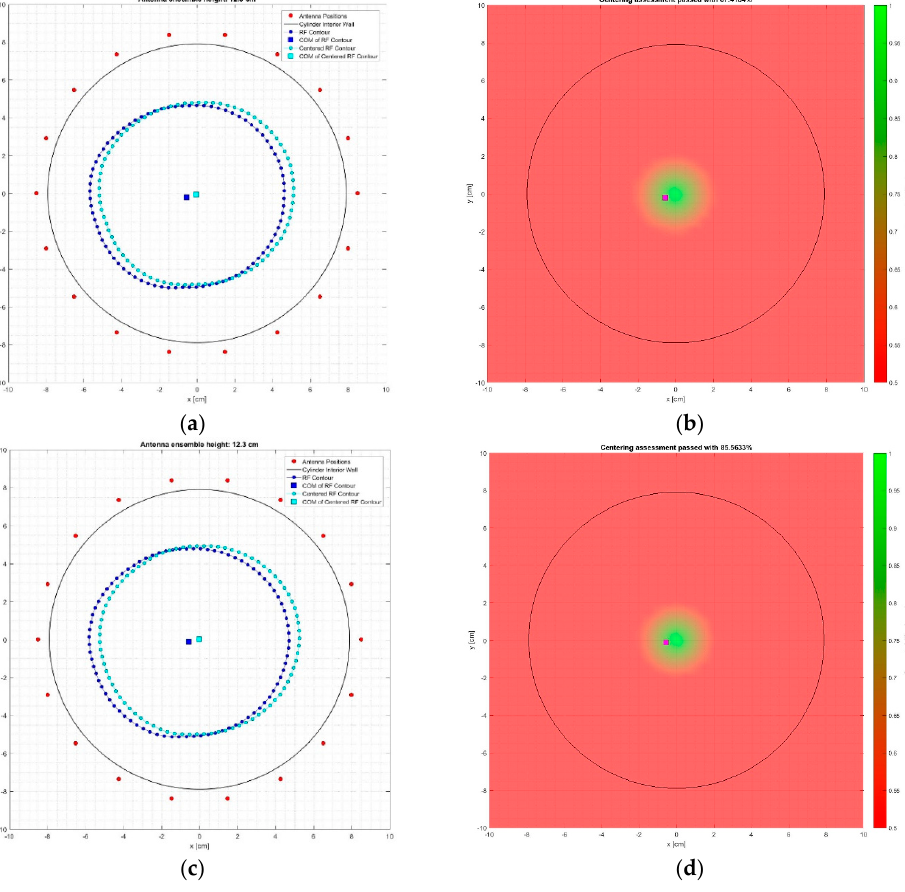
Figure 14. Breast rotational position #2: ( a ) Test Date 1, estimated outer breast surface at a given coronal slice; ( b ) Test Date 1, breast centering assessment map; ( c ) Test Date 2, estimated outer breast surface at a given coronal slice; ( d ) Test Date 2, breast centering assessment map. Table 3. Confidence Level for Breast Centering.